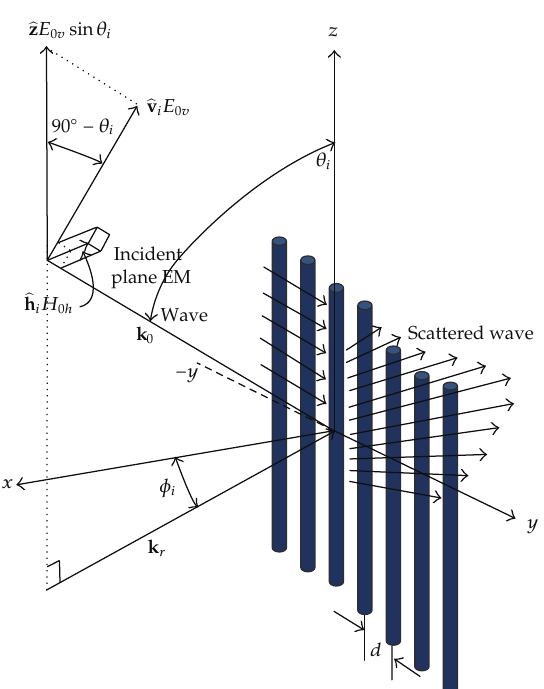
Figure 1: The configuration of the problem of scattering of waves by an infinite array of penetrable circular cylinders at oblique incidence (cid:4) side view (cid:5)